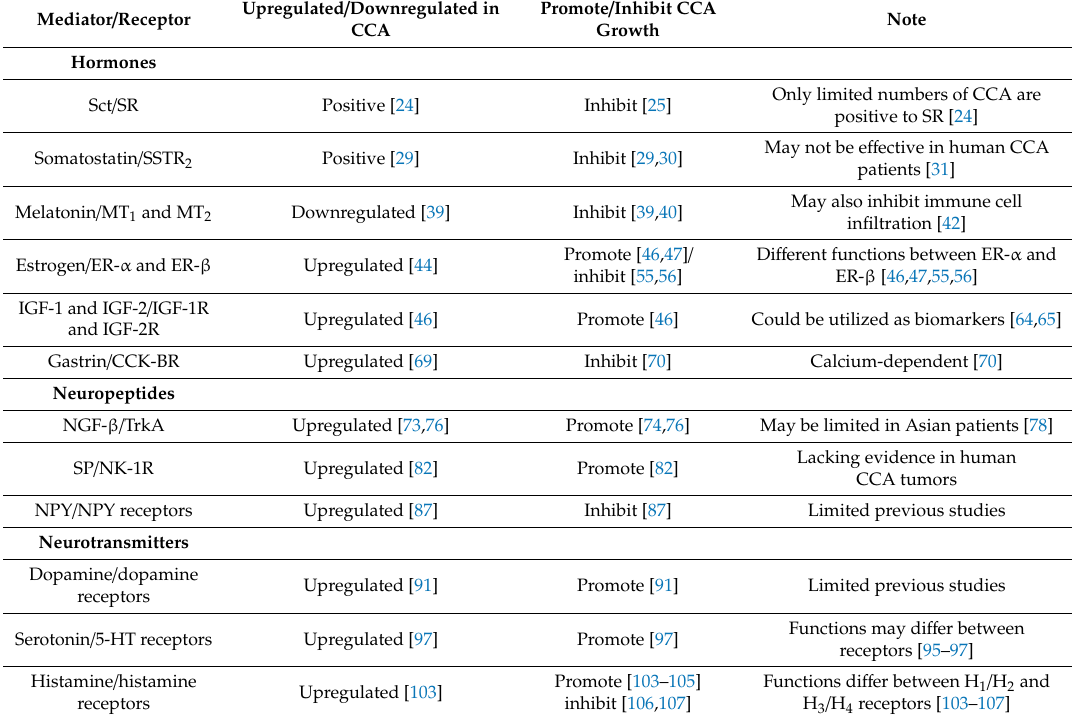
Table 1. Comparison of neuroendocrine mediators associated with cholangiocarcinoma